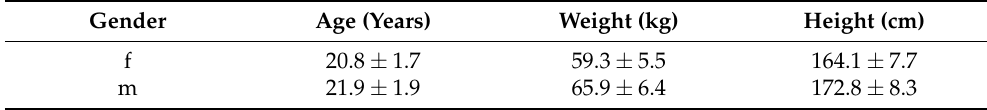
Table 1. Volunteer descriptive data (M ±